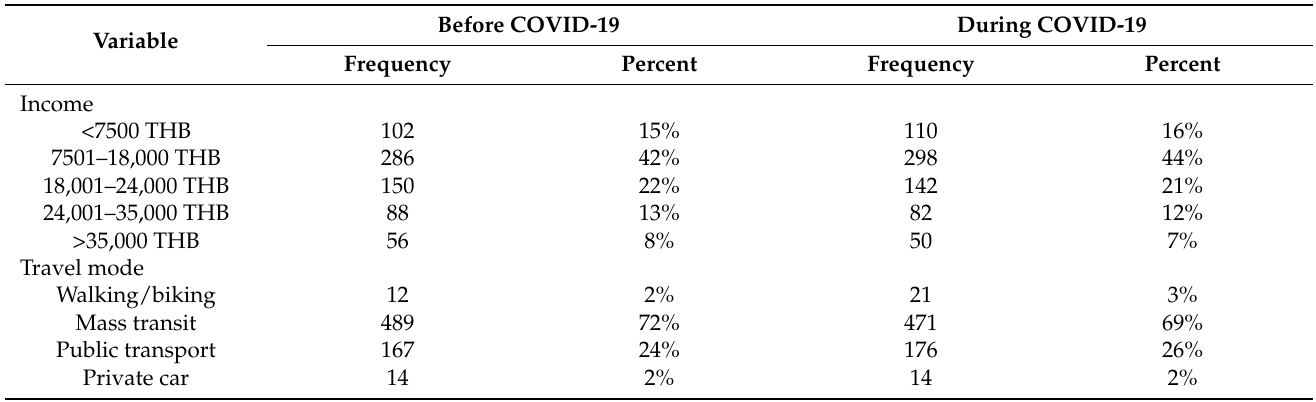
Table 2. Demographic and travel behavior change of